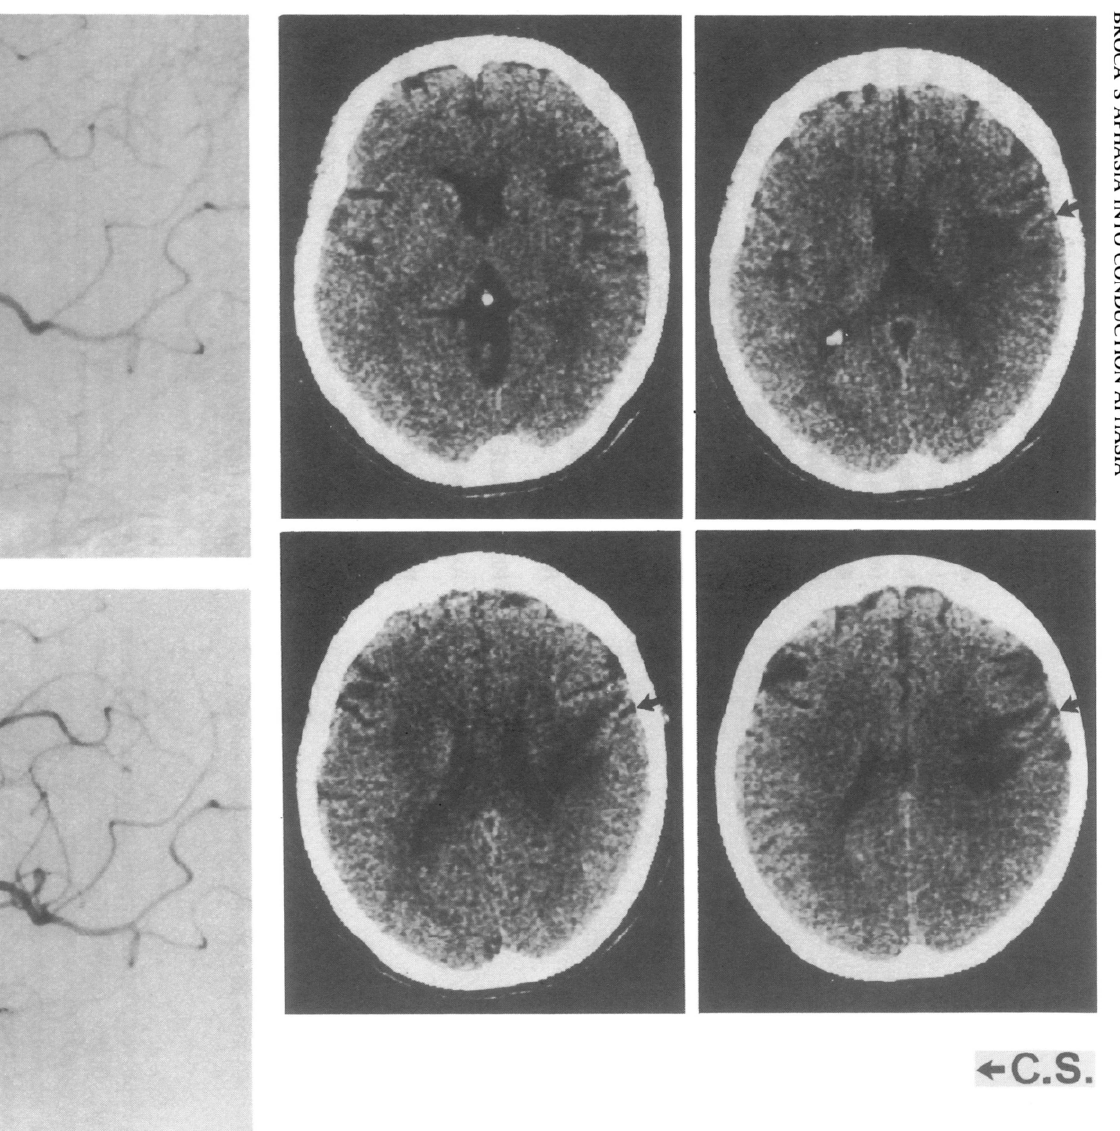
FIG. 3. Left carotid angiograms revealing occlusion of the upper trunk of the left middle cer ebral artery on admission (A), which was reopened 11 days later (8).